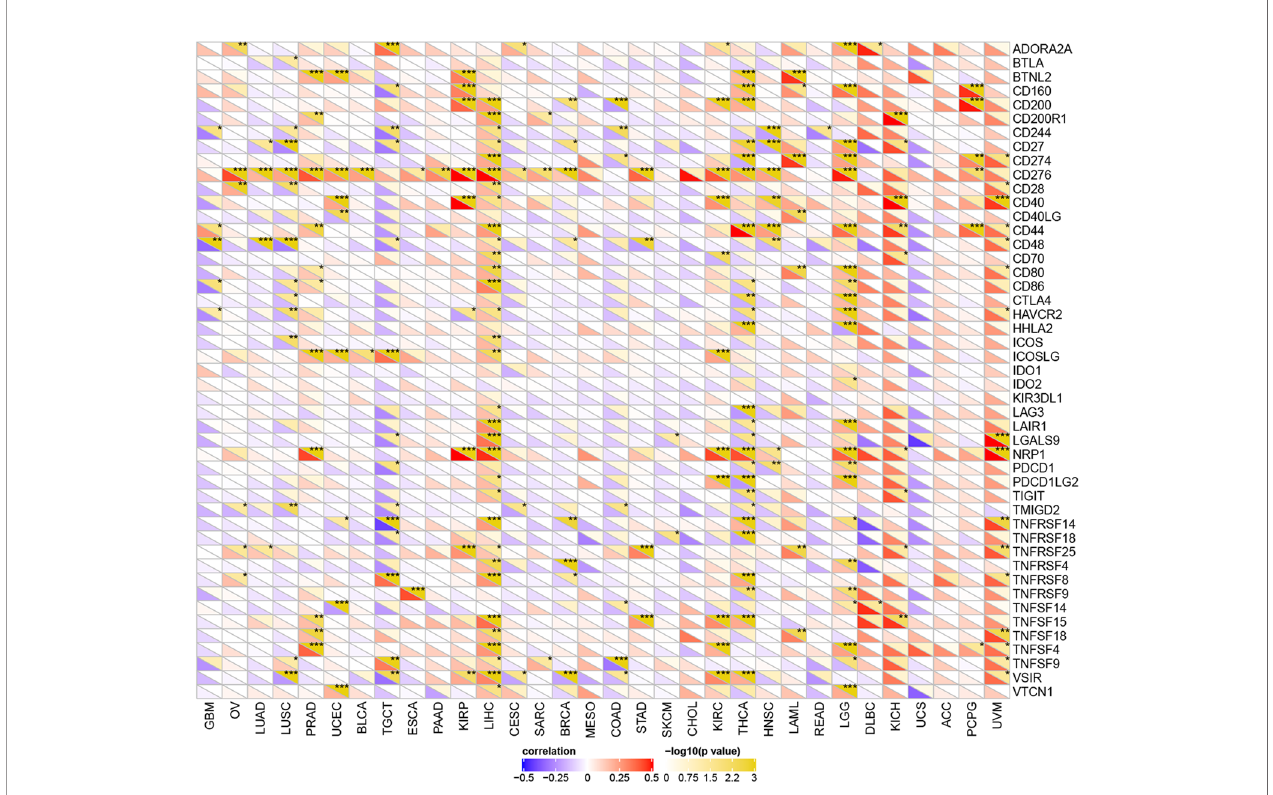
FIGURE 5 | The relationship between YTHDF1 expression and pan-cancer immune checkpoint genes. * P < 0.05; ** P < 0.01; *** P <